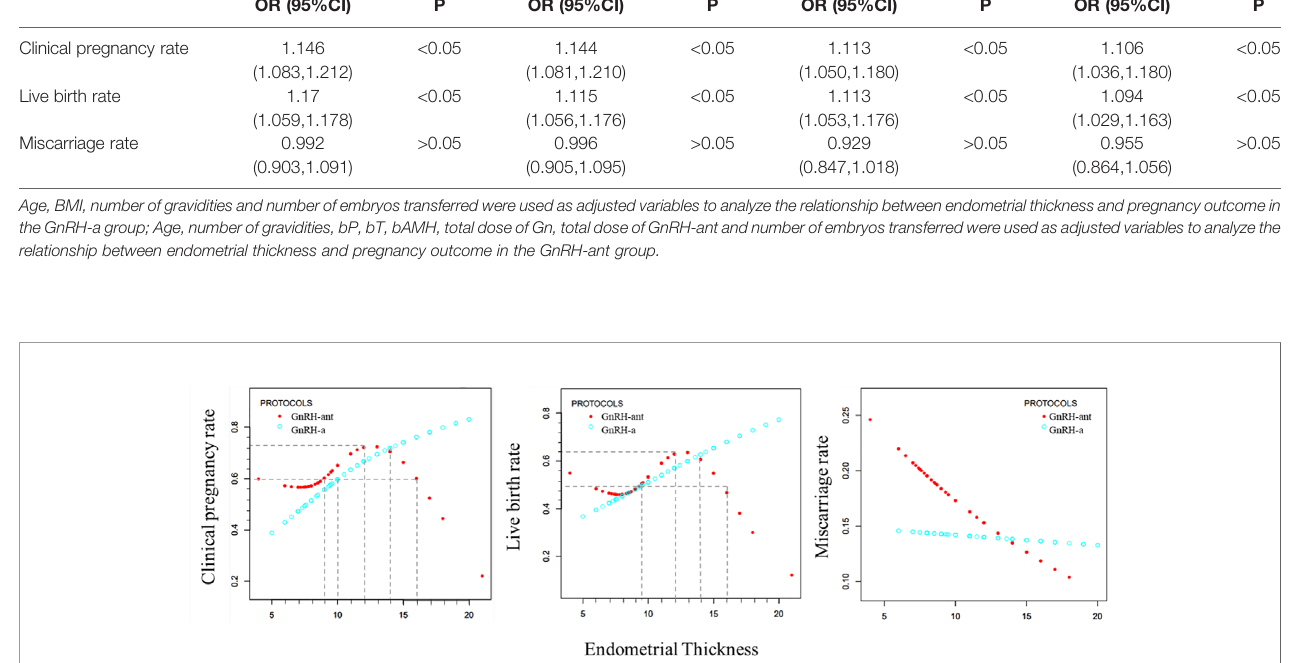
FIGURE 3 | Curve fi tting diagram of endometrial thickness and clinical outcome rate in GnRH-a long and GnRH-ant protocols.